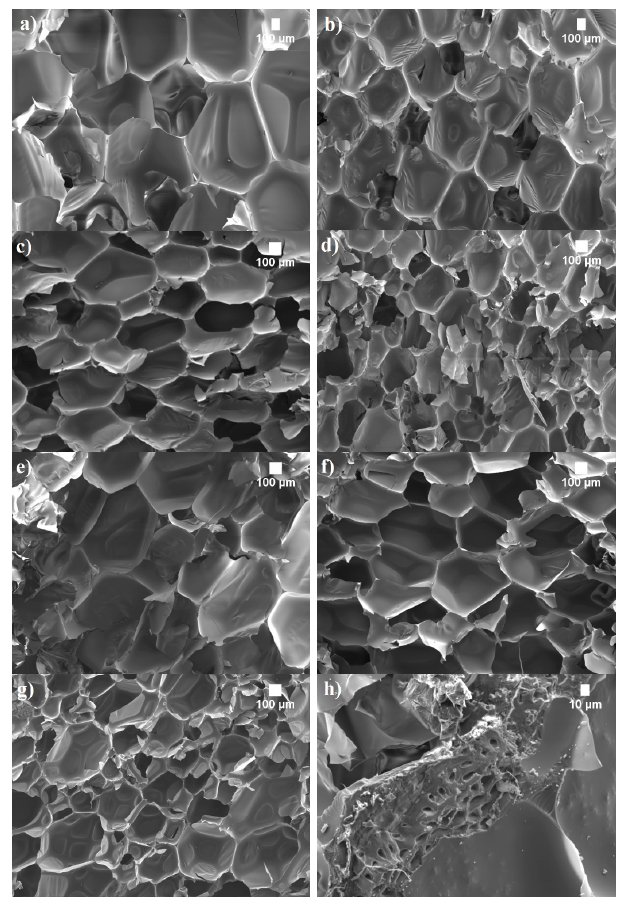
Figure 5. Microstructure of SFP and LG-SFP modified PUR foams (×50 magnification): ( a ) PUR-REF; ( b ) SFP-10; ( c ) SFP-20; ( d ) SFP-30; ( e ) LG-SFP-10; ( f ) LG-SFP-20; ( g ) LG-SFP-30 and ( h ) cut section of SFP particle in cell struts (×400 magnifi- cation).